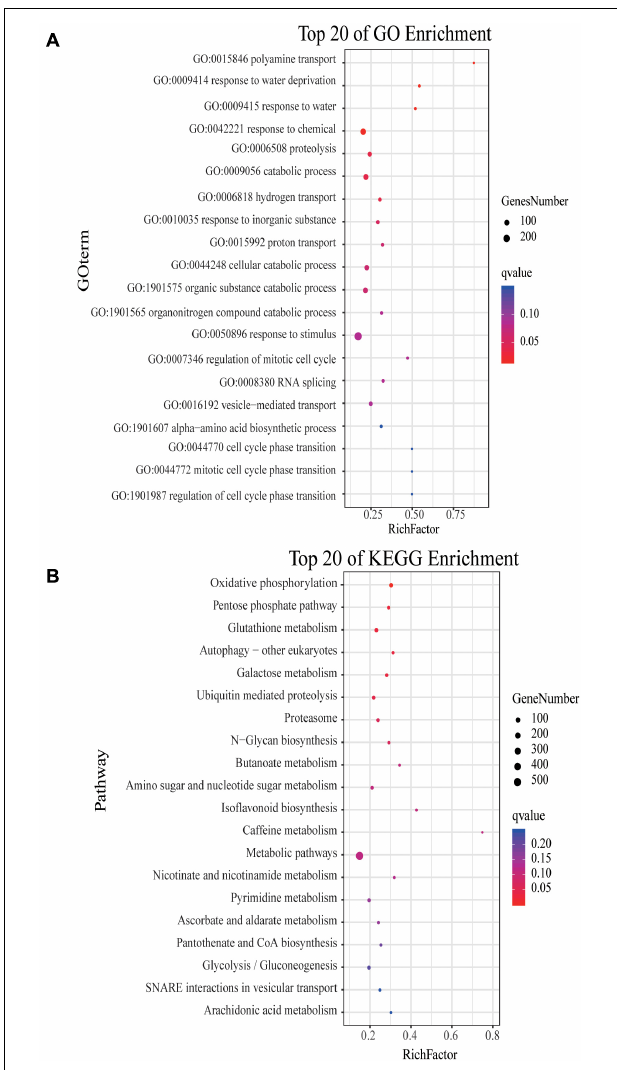
FIGURE 7 | GO and KEGG analysis of DEGs in the navajowhite1 module. (A) The top 20 of GO enrichment. (B) The top 20 of KEGG enrichment. (The q -value ranges from 0 to 0.05. The closer the q -value is to 0, the more significant the enrichment is. Genes number is the number of genes enriched in